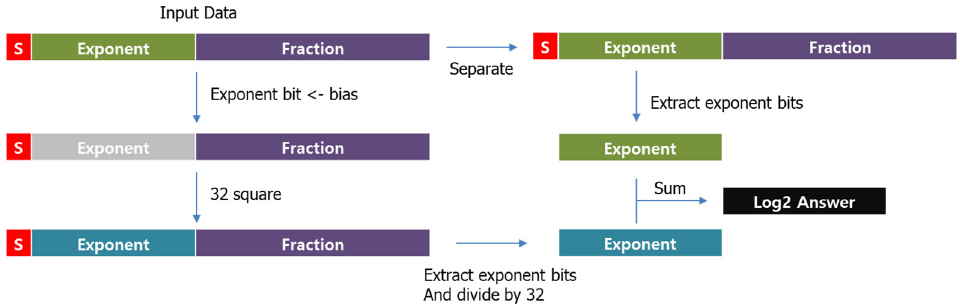
Figure 3. SIMD operation for logarithm operation by exponential division and power in the proposed method.